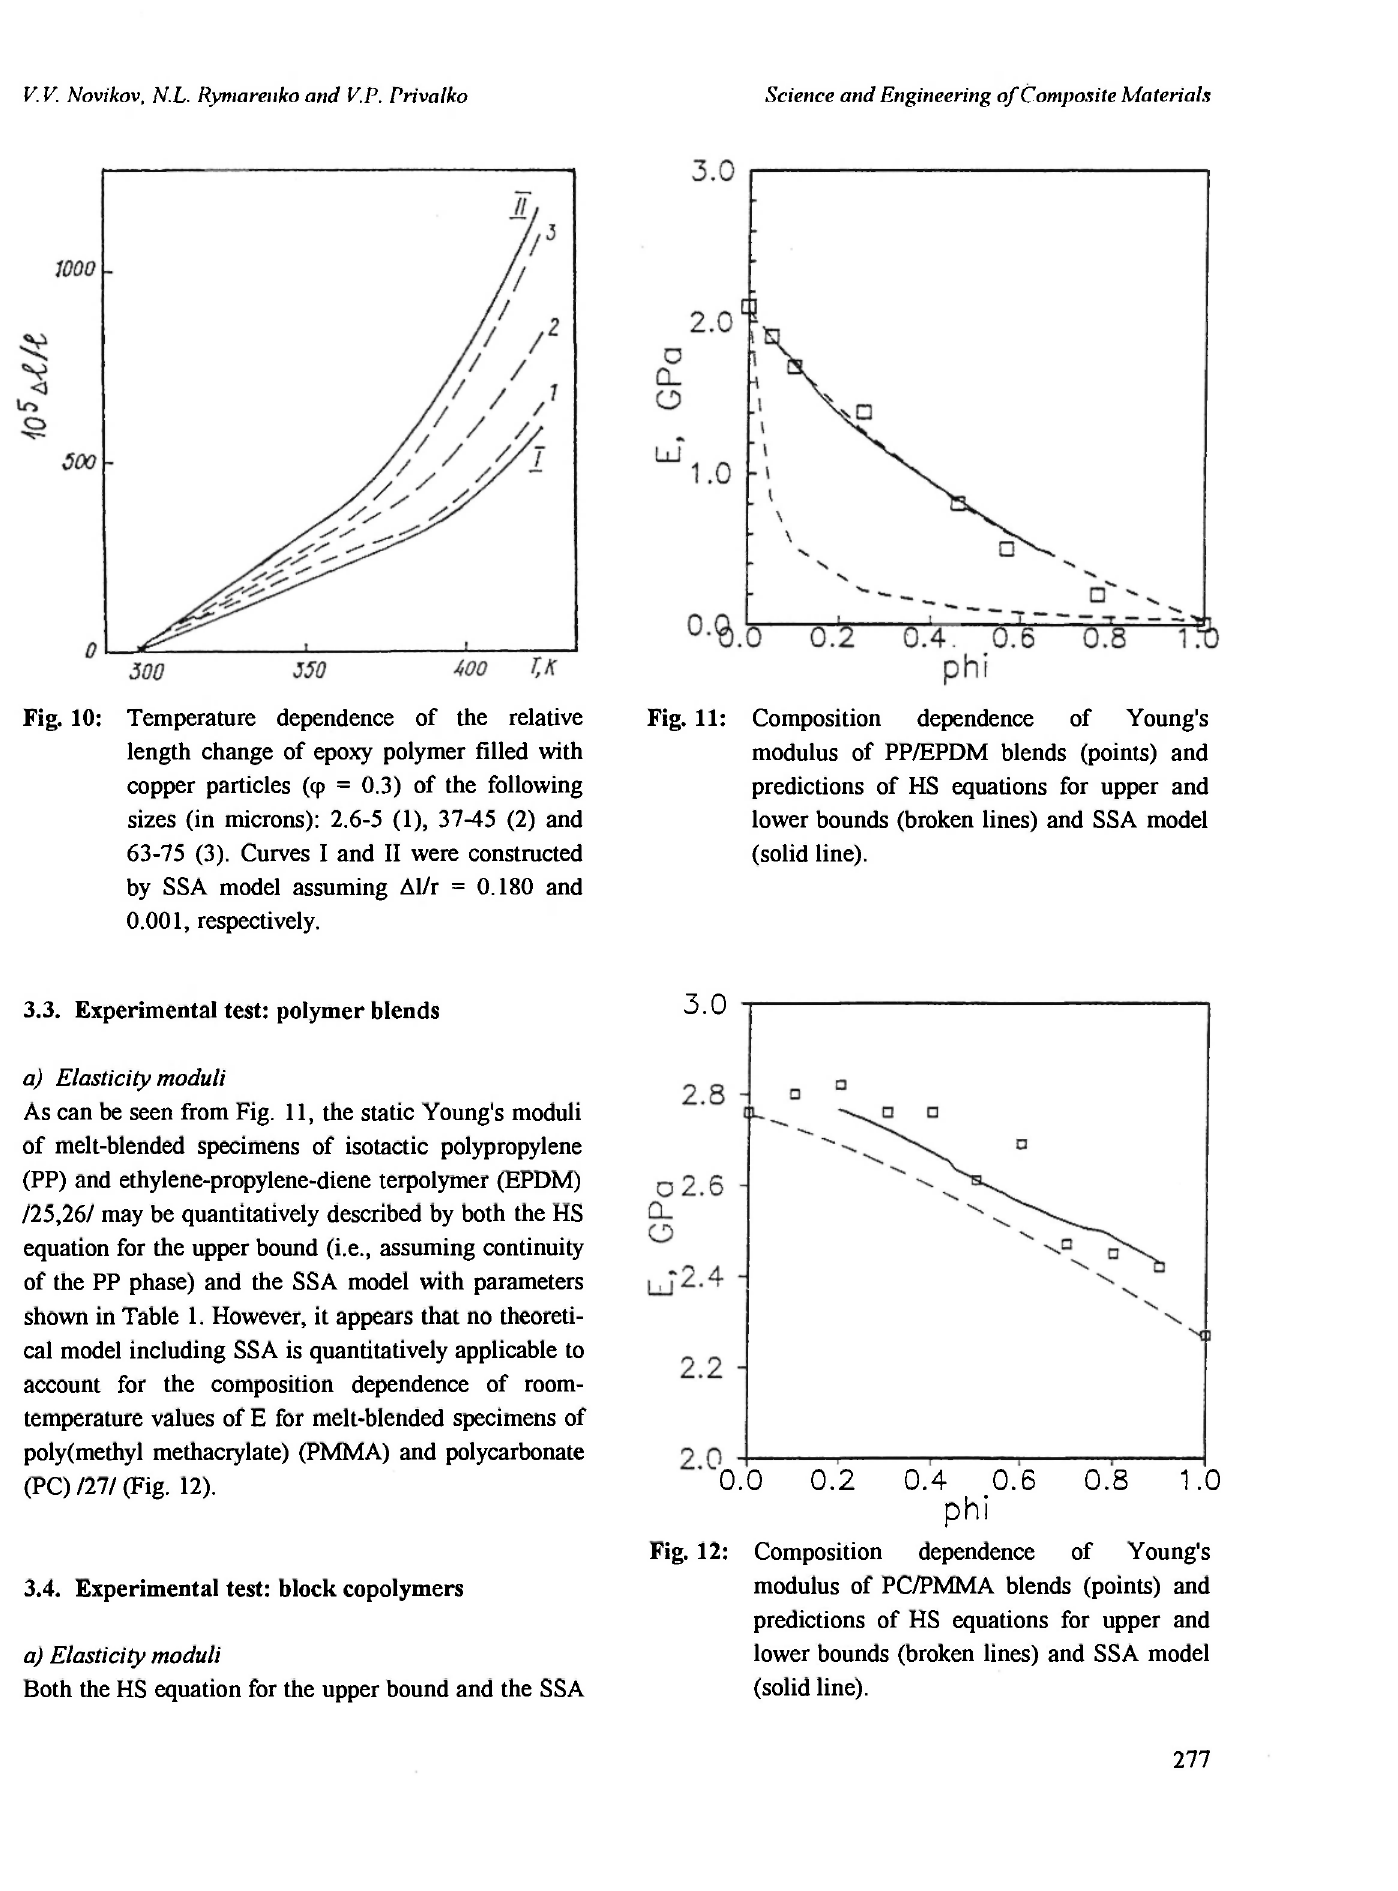
Fig. 12: Composition dependence of Young's modulus of PC/PMMA blends (points) and predictions of HS equations for upper and lower bounds (broken lines) and SSA model (solid line).